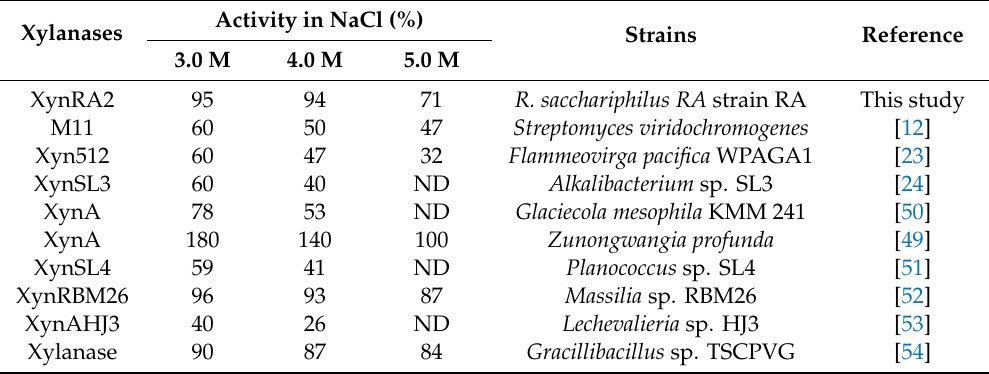
Table 1. The reported halo-tolerant xylanases and their activity in high concentration of NaCl. Enzymatic reactions carried out at 0 M of NaCl was treated as